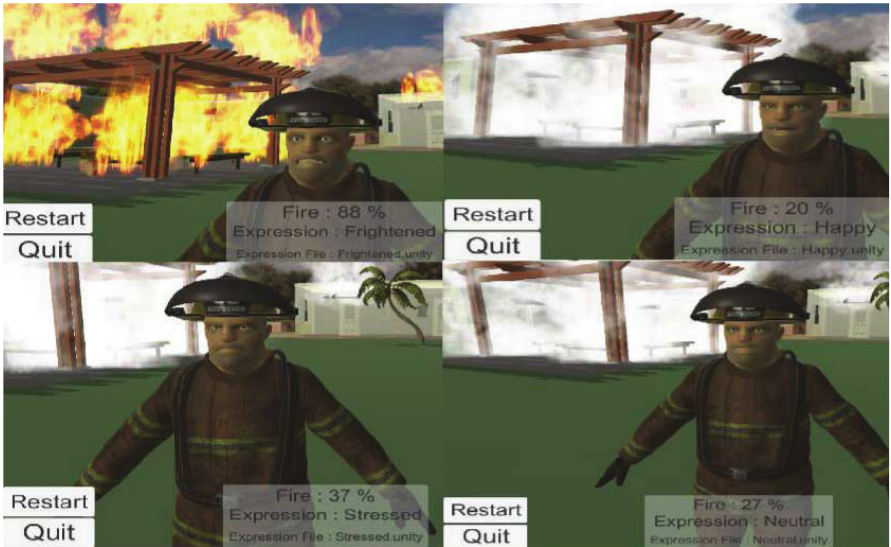
Figure 6: Firefighter face